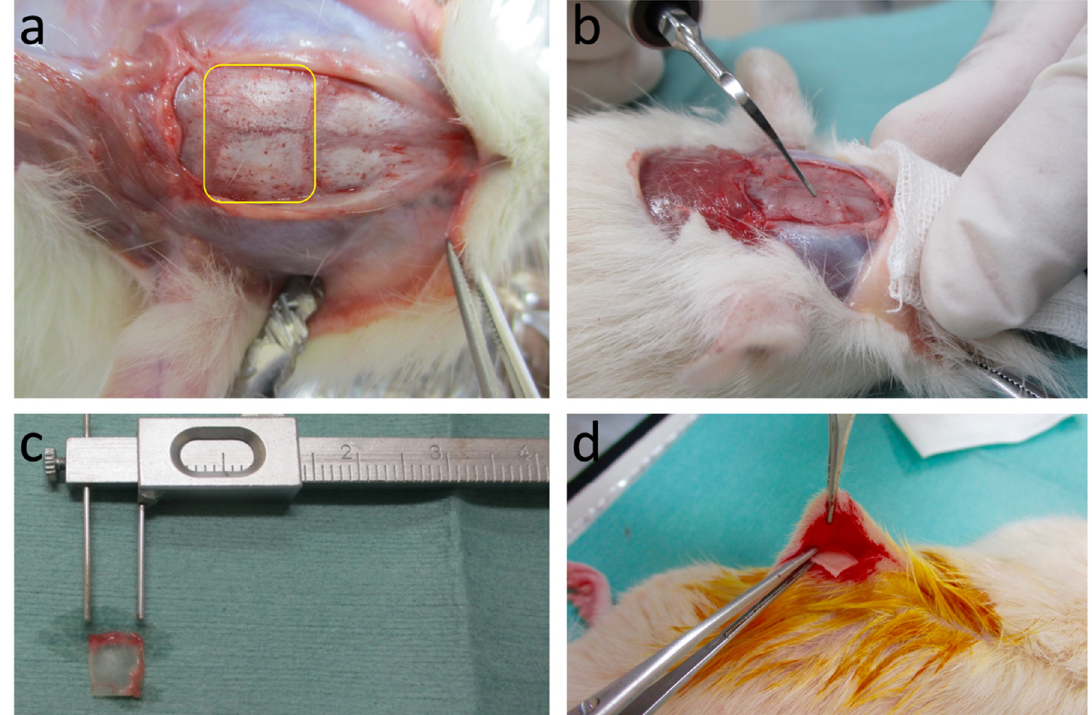
Figure 2. Preparation of graft material. ( a ) Exposure of parietal bone (yellow box) after reflection of full thickness skin flap. ( b ) Exposed surface treated by piezo-ultrasonic scaler tip using AEW or DW irrigant. ( c ) Treated bone prepared on plate size (5 × 5 × 1 mm 3 ). ( d ) Placement of prepared graft into subcutaneous pouch of recipient rat.